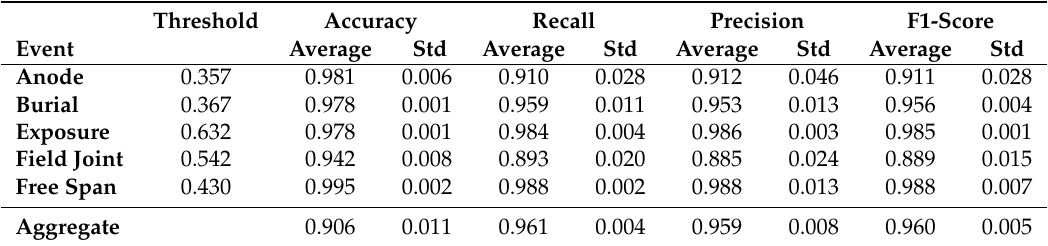
Table 3. Metrics with optimal thresholds on the validation set.